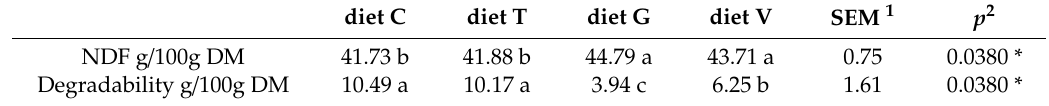
Table 1. Neutral detergent fibre (NDF) degradability among feeds. diet C diet T diet G diet V SEM 1